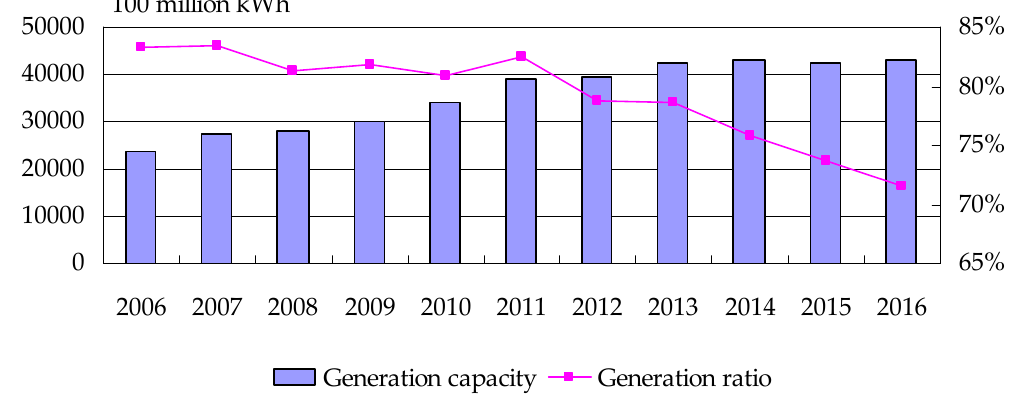
Figure 1. Generation capacity and generation ratio of thermal power in China.